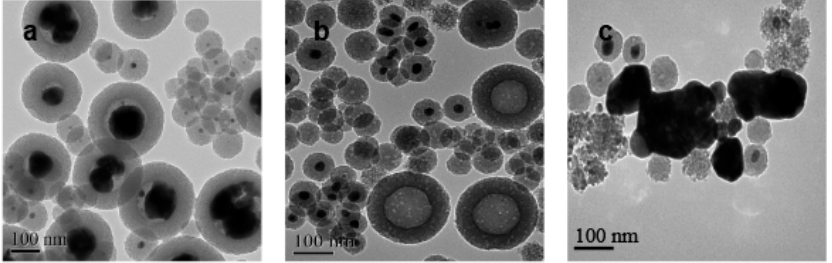
Figure 4. Characterization of the prepared Ag@SiO 2 nanoparticles by TEM images: prepared at low concentration of C 7 H 6 O ( a ) before and ( b ), ( c ) after nitrobenzene hydrogenation.